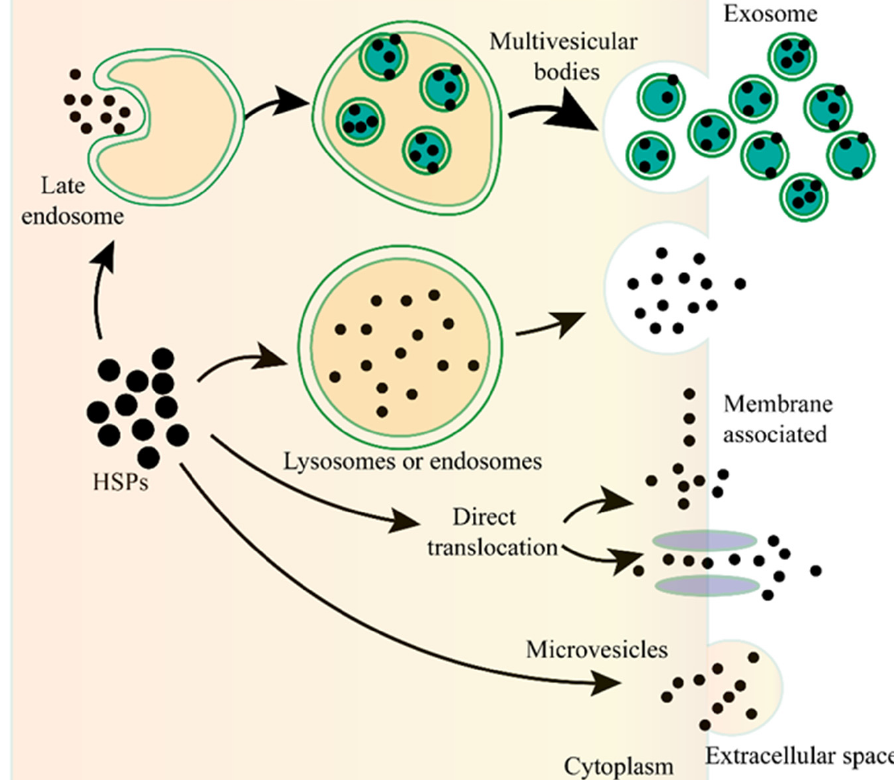
Figure 1. The unconventional secretion of Heat shock proteins (HSPs) outside the cell. After fusion of the lysosome or endosome with the plasma membrane, the HSPs can be released to the outside of the cell. HSPs captured from the cytoplasm can form vesicles, leading to the biogenesis of multivesicular bodies, and these internal vesicles are released outside the cell to become exosomes. HSPs can be directly translocated from the cytoplasm across the plasma membrane with or without the ATP binding cassette (ABC) transporter. HSPs can also be released into the extracellular space via microvesicles shed from the cell surface.